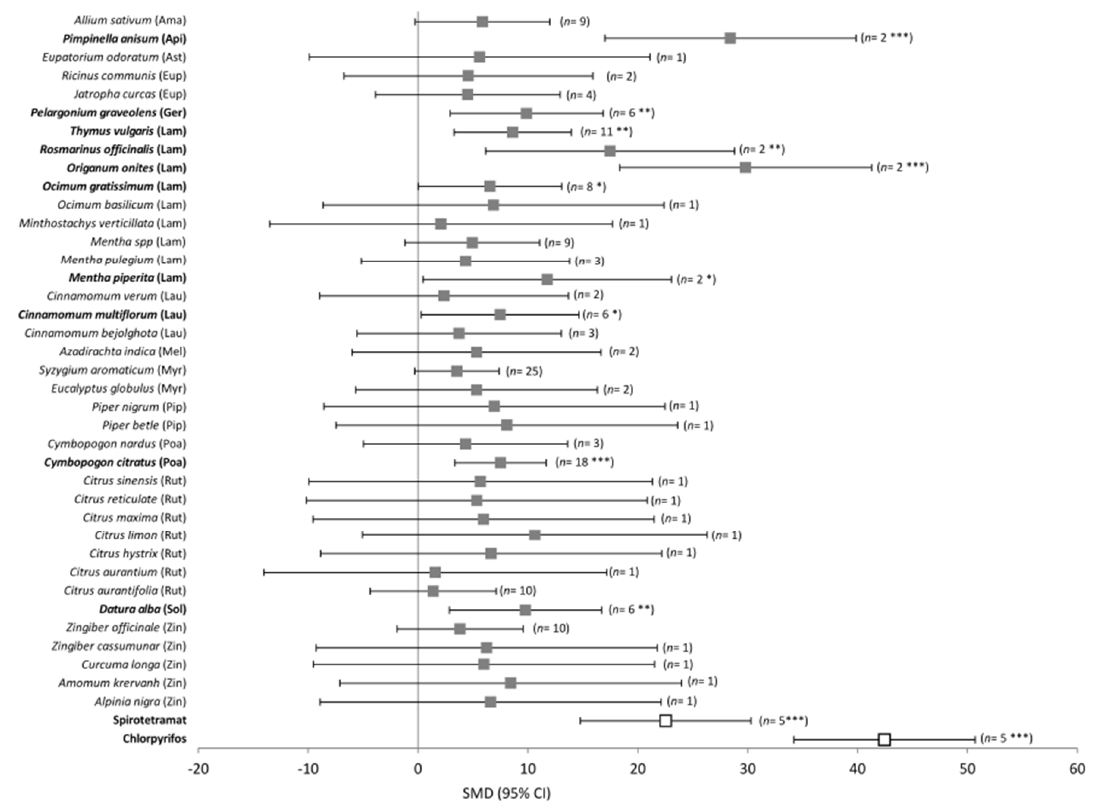
Figure 3. Meta-analysis of the insecticidal effect of EOs against mealybugs of the Pseudococcidae family using the plant species as a moderating variable. Spirotetramat and chlorpyrifos are synthetic insecticides (white squares) used to compare their activity with the EOs ones (black squares) Abbreviations as in Figure 2. SMD: standardized mean difference; CI: confidence interval. The EOs from plant species with significant effects are shown in bold. *** p < 0.001, ** p < 0.01, and * p < 0.05.